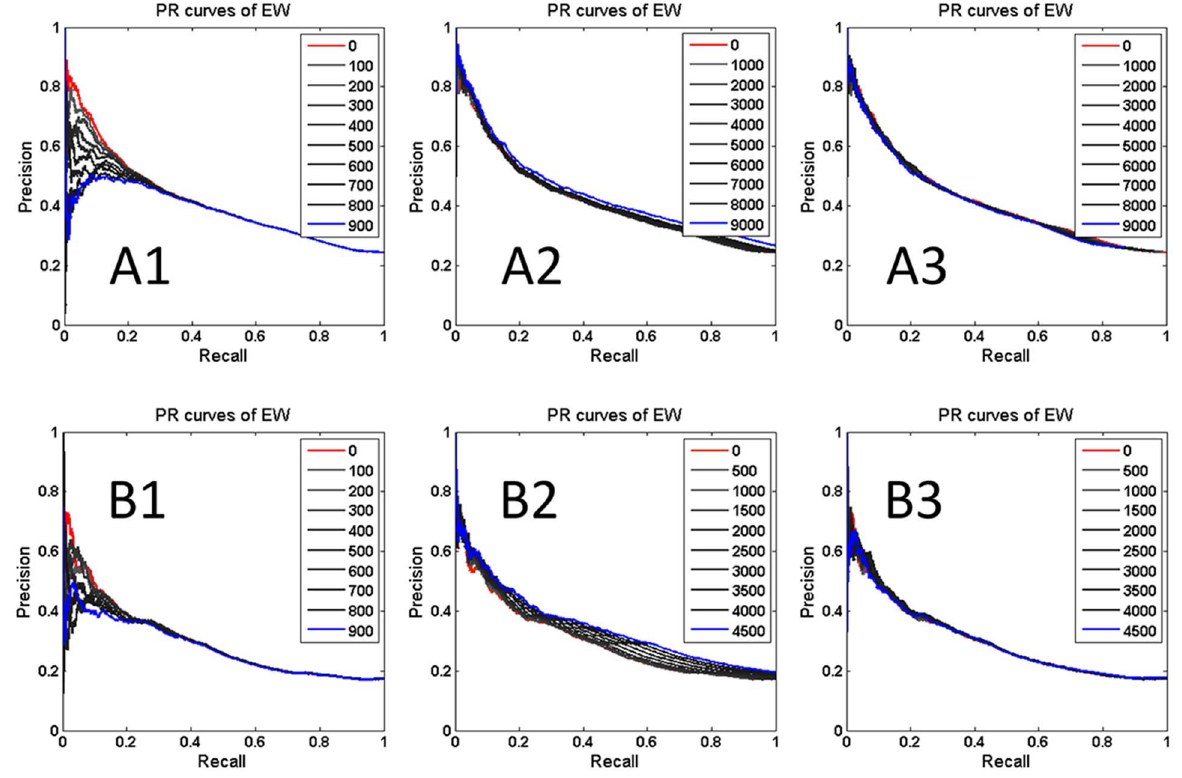
Figure 3. PR curves of EW methods on the perturbed Yeast and E.coli PPI networks for essential protein identification. The PPI networks are perturbed from the top, the bottom and randomly by deleting X edges in 10 steps in the ranked EW edge list. ( A1, B1 ) From the top for X=100 on Yeast and E. coli ; ( A2, B2 ) Form the bottom for X=1000 and 500 on Yeast and E. coli , respectively; ( A3, B3 ) For X=1000 and 500 randomly on Yeast and E. coli , respectively.